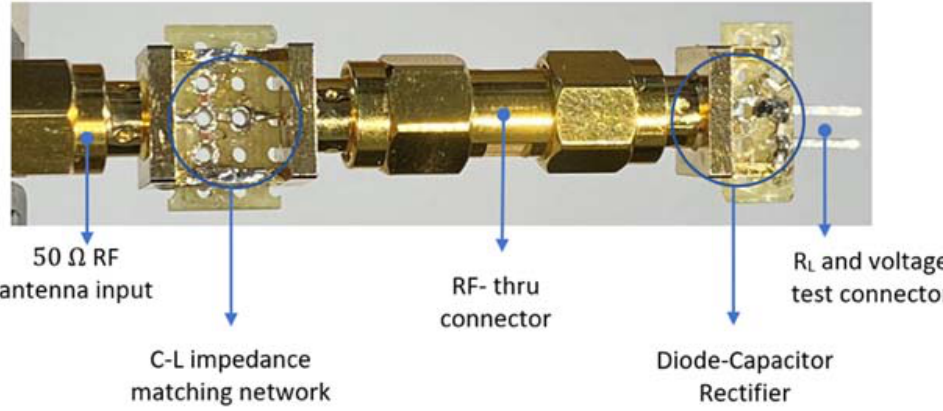
Figure 6. Implemented prototype of an ambient RF energy harvesting system composed by the input antenna port, the C-L impedance network, a thru connector, the diode-capacitor rectifier, and a connector to the load resistor. Fabrications have been performed using the following: SMS-7630 [33] diode, capacitors from the HiQ-CBR Series, Case Size 0402 Radio Frequency and Microwave Ceramic Capacitor Kit from Kemet, and the inductors from the High Frequency Inductor Designer Kit EIA 0402 from Johanson